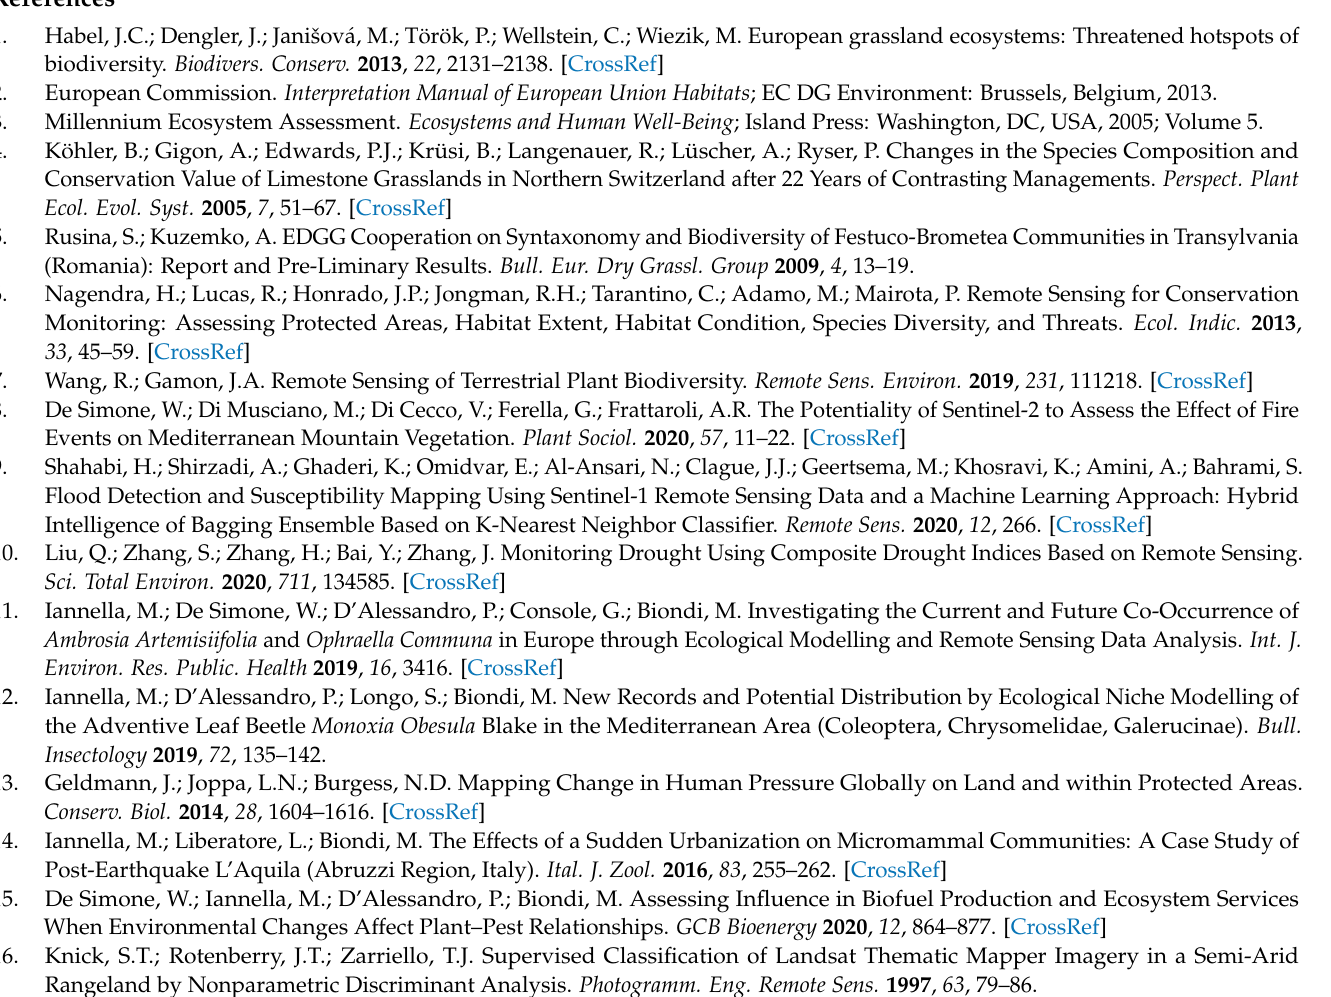
Figure S2: Results of the area of applicability (AOA) analysis. Table S3: Accuracy statistics. Figure S4: Maps derived from Local Indicators of Spatial Association (LISA) analysis of the classified B. genuense patches. Table S5: Plant associations recognized in the study